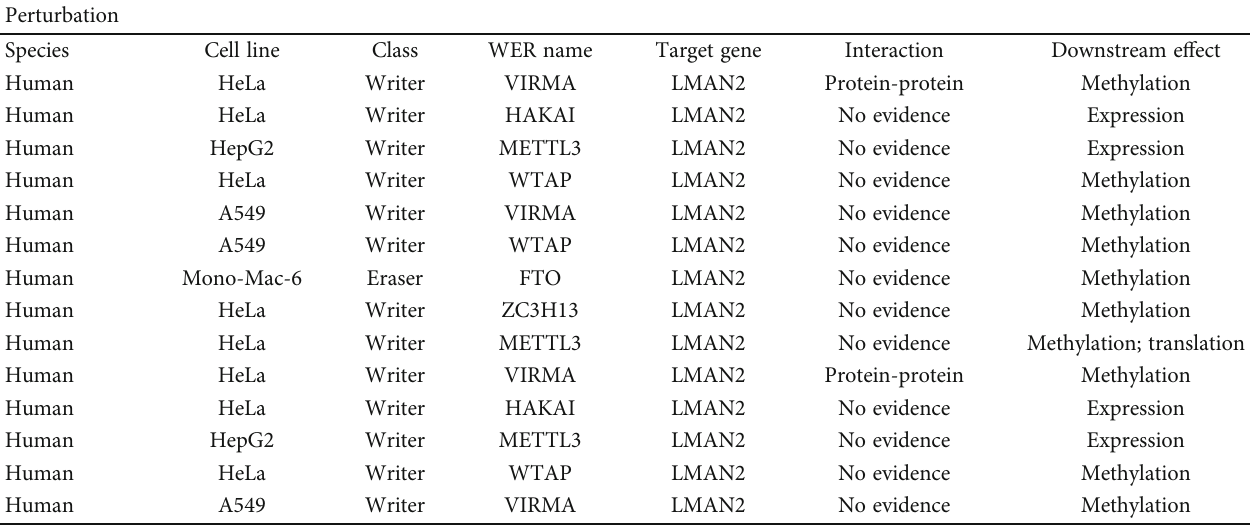
Table 5: The di ff erential expression, di ff erential translation e ffi ciency, or di ff erential methylation genes upon perturbation of WERs.